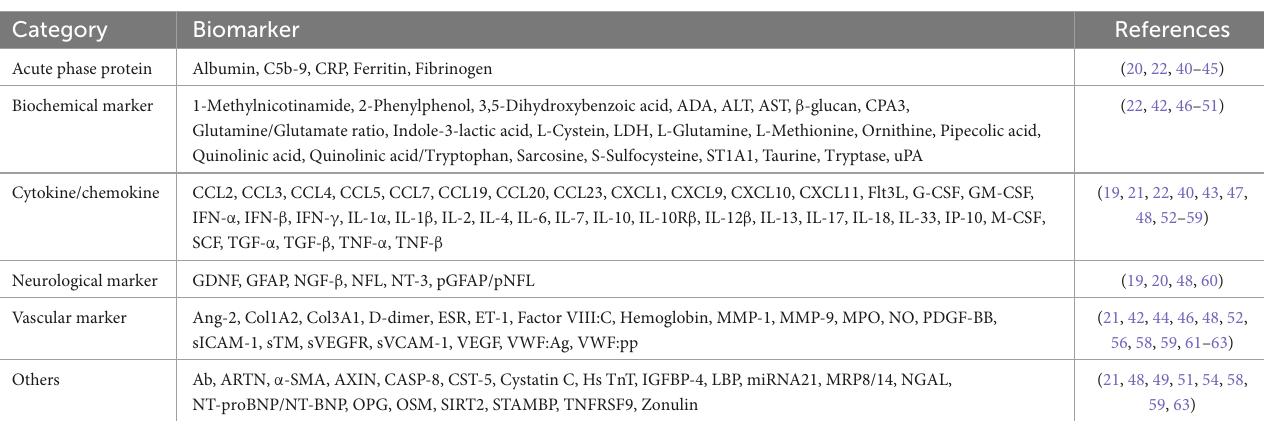
TABLE 1 Categories of biomarkers significantly associated with long COVID